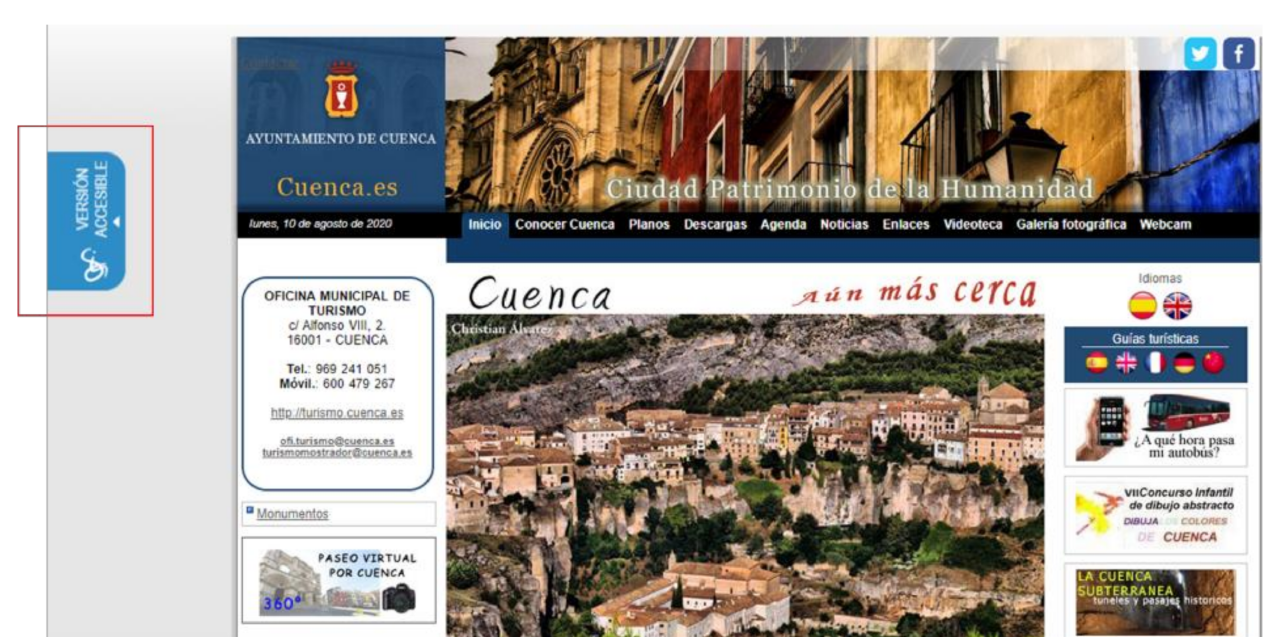
Figure 10. Example of one of the analyzed websites showing the presence of an accessible embedded software that allows it to be activated by users. Source: own